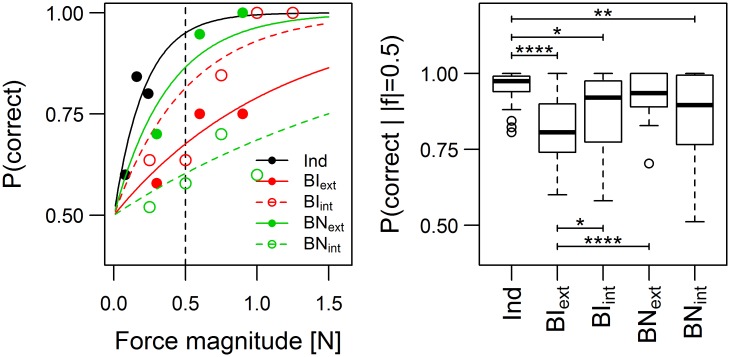
Individual probability of correct response.Left: Probability of correct response as a function of the force magnitude (interaction force or external force) for one participant in all conditions. Probability curves correspond to Eq 5. Right: Probability of participants correctly identifying the direction of a force of 0.5 N in the individual (Ind) and joint conditions. For the joint conditions, both the probability of identifying the direction of the external force (BIext, BNext), and the probability of identifying the direction of the interaction force (BIint, BNint) are shown. * p<0.05; ** p<0.01; *** p<0.001; **** p<0.0001.